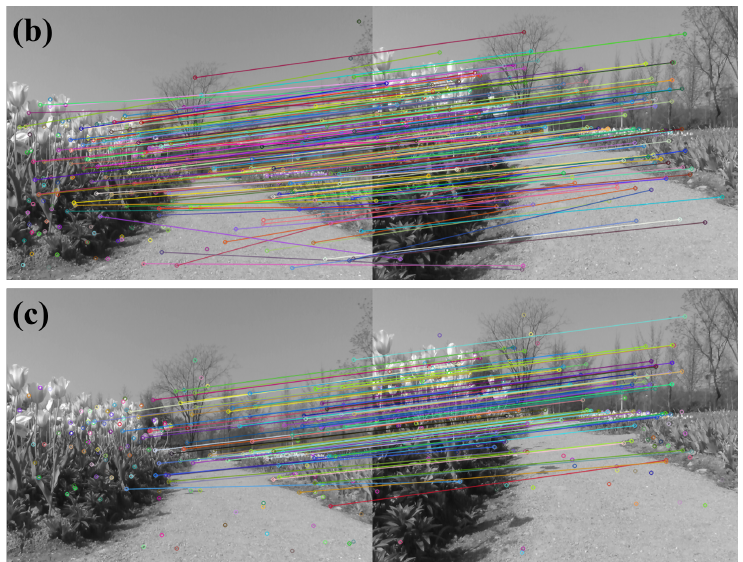
Figure 15. Experimental results of a normal light scene under different algorithms: ( a ) BF matching;